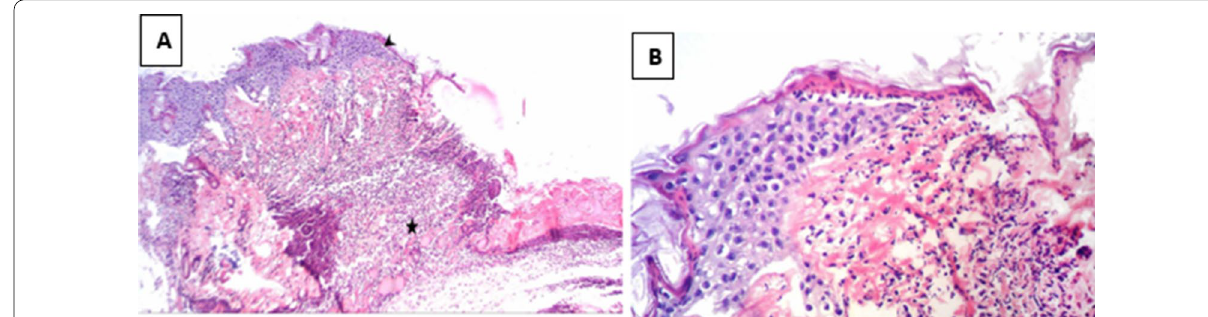
Fig. 6 A . Histopathology of skin from Group 2 (burned, infected, treated with vehicle). Wounded region with incomplete epithelial bridging by epithelial edge (arrow head), attenuated dermis with area of denudation on the right side and sever inflammatory cells infiltration in dermal full thickness as well as subcutaneous tissue and underlying skeletal muscles (star). B Higher magnification from ( A ) showing wound epithelial edge with underlying inflammatory cells infiltration in dermal layer (H&E 400X)